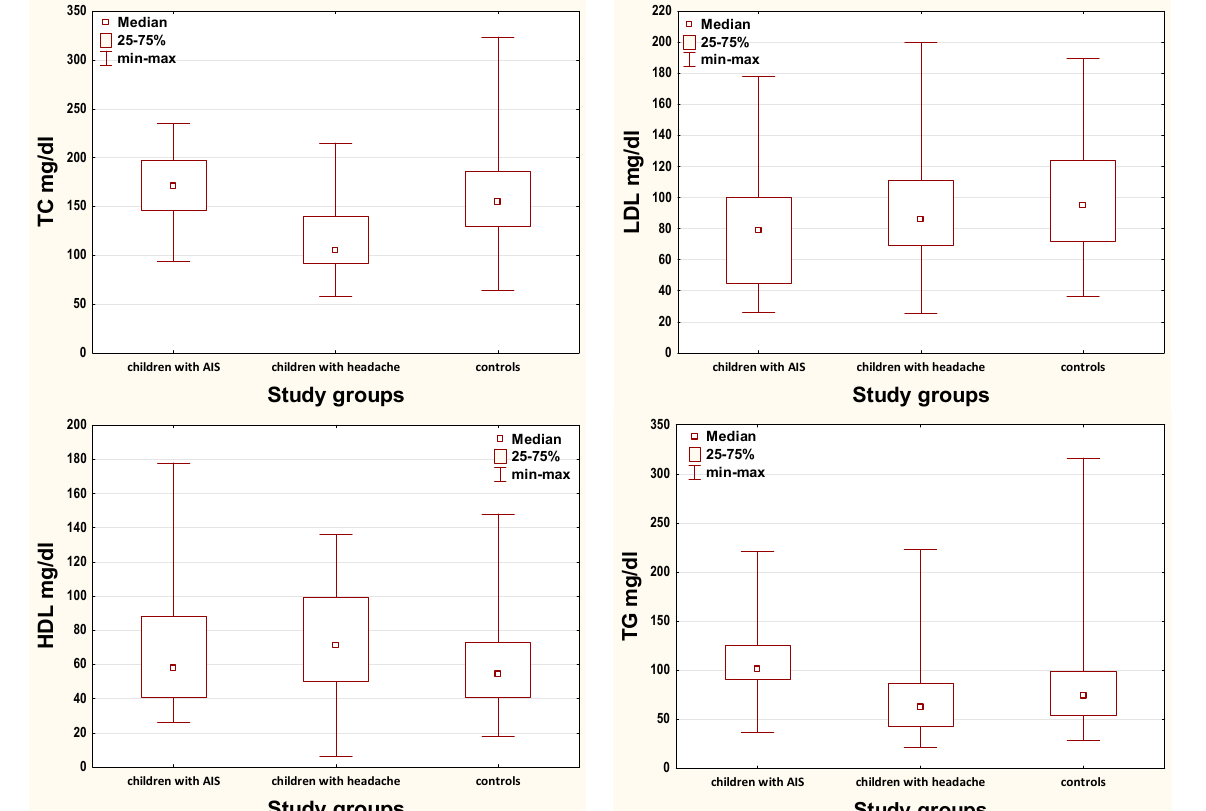
Figure 1. Box plots show median concentrations, interquartile range (the 25th to the 75th percentile of lipid parameters) and min-max. p values were determined by the Kruskal—Wallis test for comparison of three groups. For TC, HDL and TG parameters median test revealed statistical significance (TC: χ 2 = 25.77, df = 2, p < 0.001; LDL: χ 2 = 5.27, df = 2, p = 0.072; HDL: χ 2 = 7.54, df = 2, p = 0.023; TG: χ 2 = 55.28, df = 2, p < 0.001). AIS—arterial ischemic stroke; TC—total cholesterol; LDL—